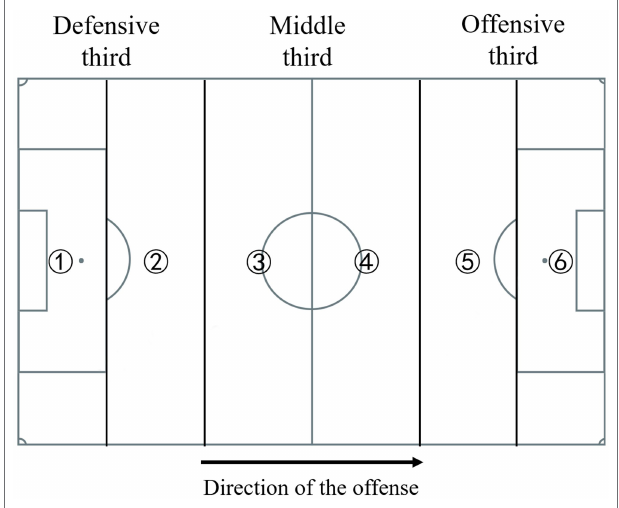
FIGURE 1 | Pitch divisions in six zones parallel to the goal lines. ① represents zone 1; ② represents zone 2; ③ represents zone 3; ④ represents zone 4; ⑤ represents zone 5; ⑥ represents zone